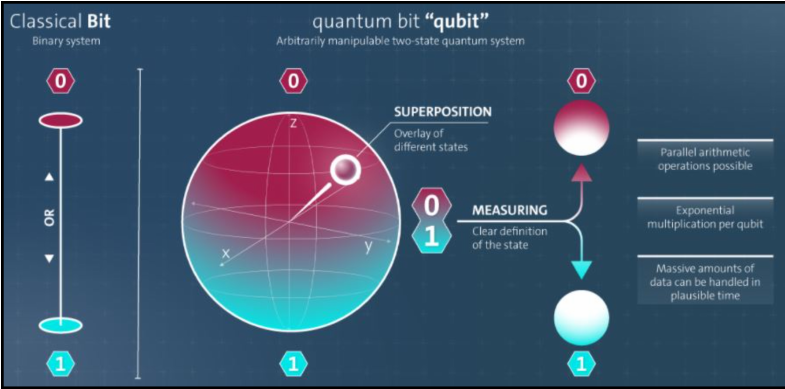
Figure 2. Classical Bit vs. Quantum